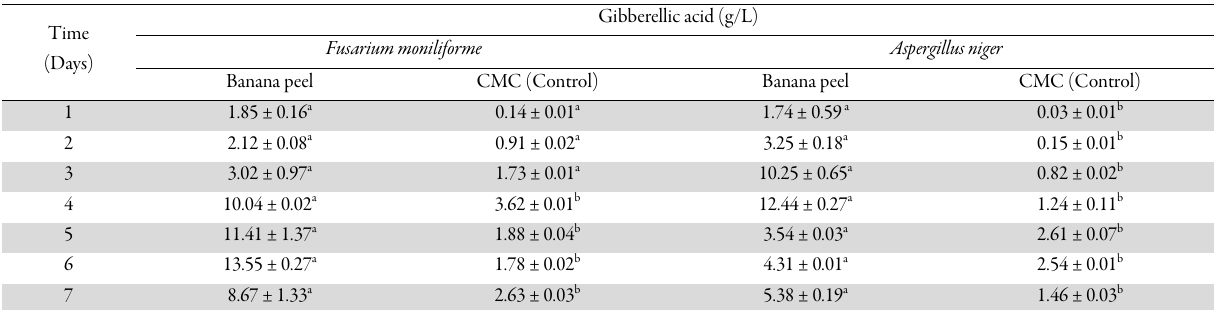
Table 1. Production of gibberellic acid by submerged fermentation of banana peel using Fusarium moniliforme and Aspergillus niger Time